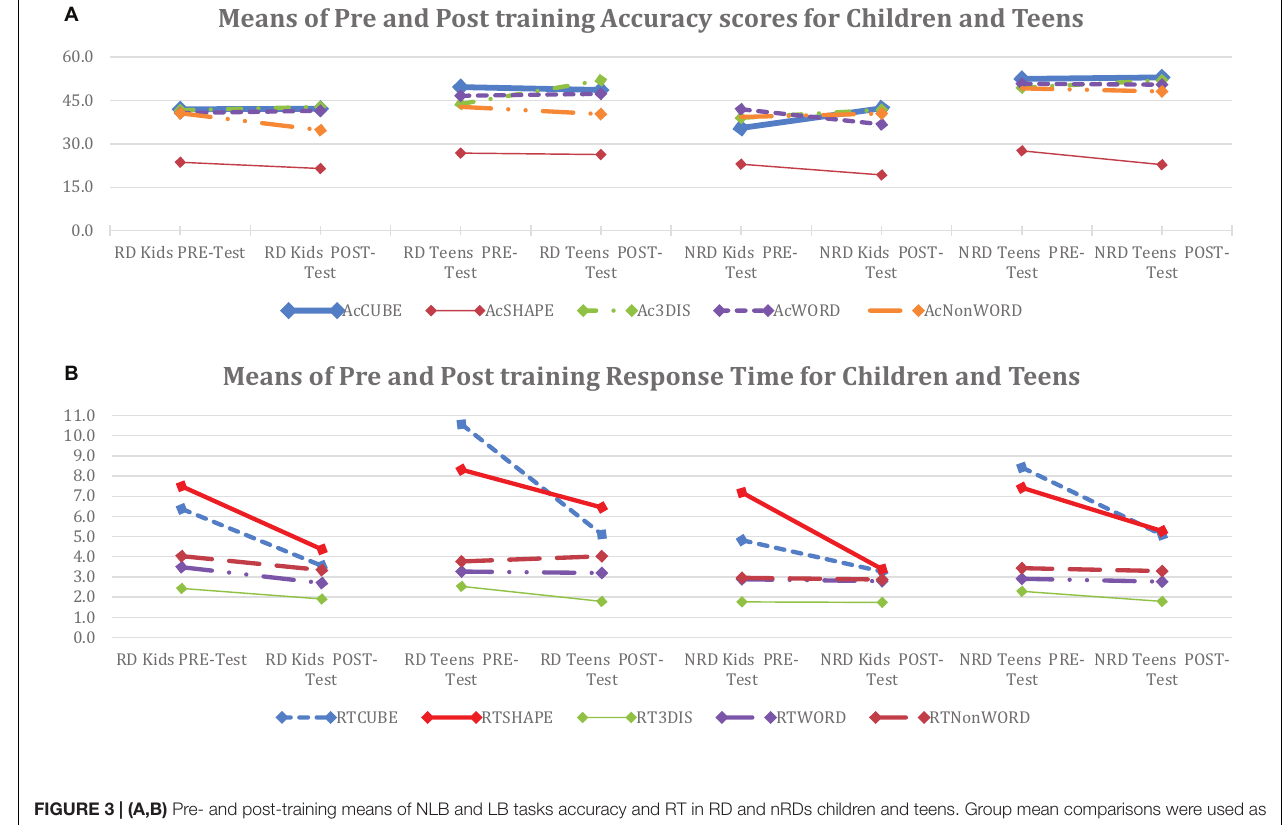
elsewhere, for example, in the way we teach and the way we support and train